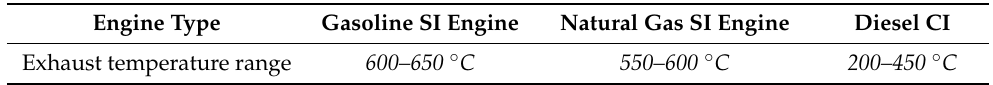
Table 1. Exhaust temperature of di ff erent engine types.